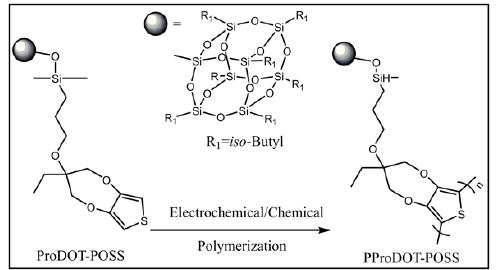
Figure 5. Synthetic procedure of the PBI-bridged amphiphilic polymer POSS-PBI-PNIPAM [74].